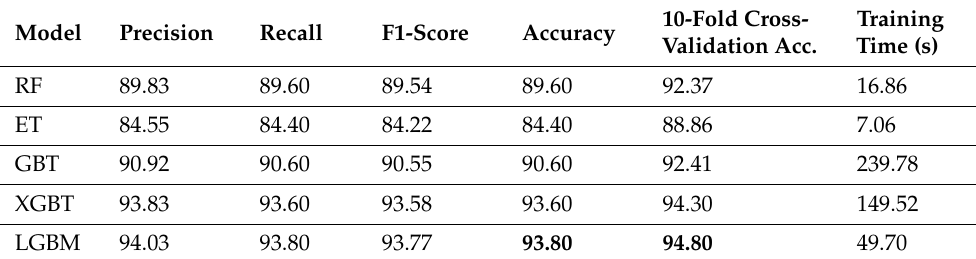
Table 7. Results on the test set with 60 packets as input.